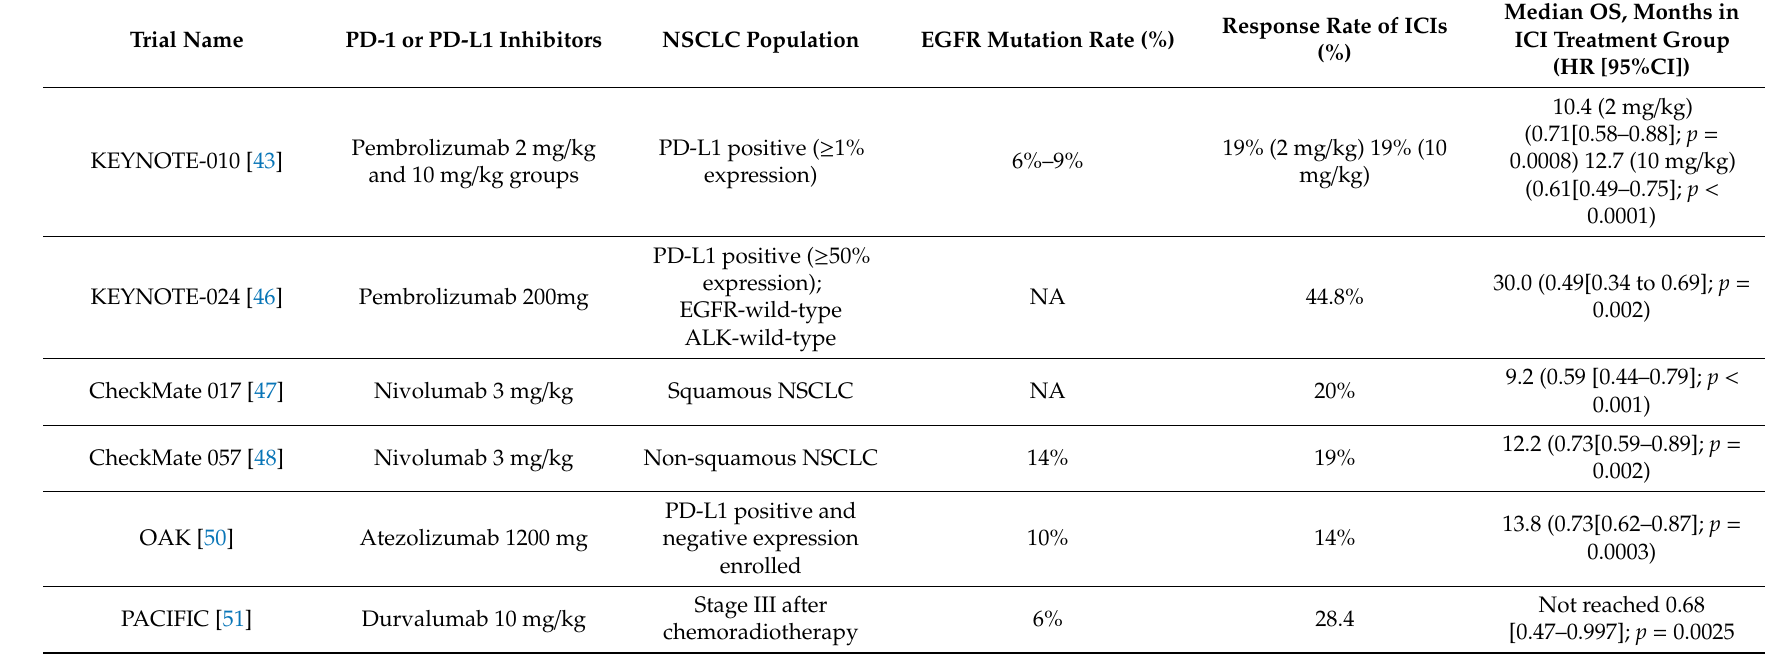
Table 2. Summary of anti-PD-1 / PD-L1 immune checkpoint inhibitor (ICI) monotherapy in clinical